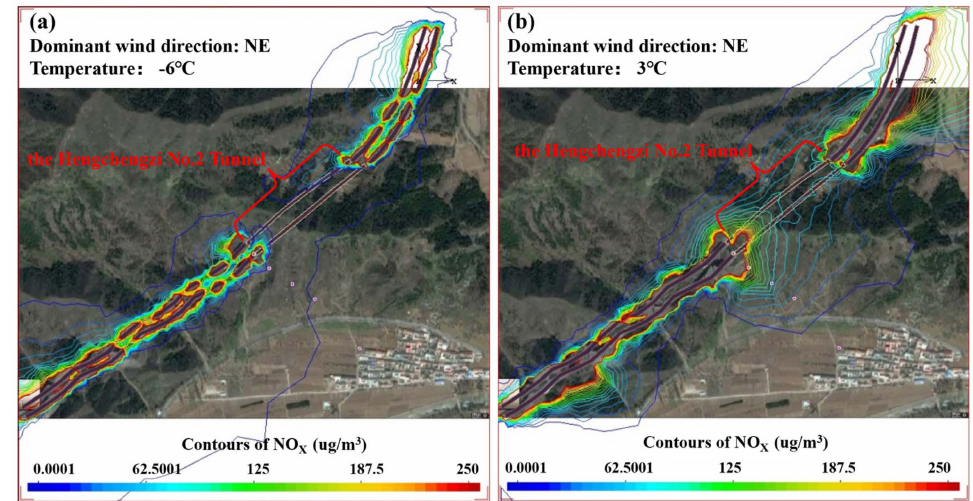
Figure 15. Average concentration distribution of NOx in the Hengchengzi No. 2 Tunnel section.